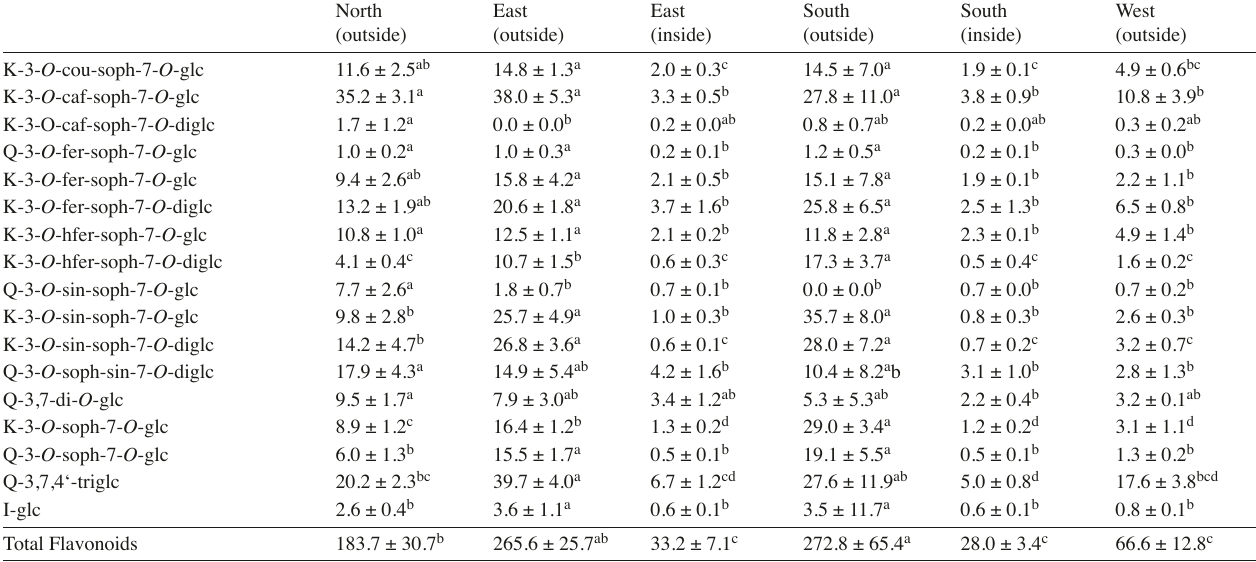
Tab. 2: Flavonoid glucosides [mg * 100 g -1 FW] in kale leaves harvested after 7 weeks of growth under urban gardening conditions in northern, eastern, western, and southern locations, including 2 indoor locations (east and south). Different letters indicate significant differences of means according to Tukey’s test (p ≤